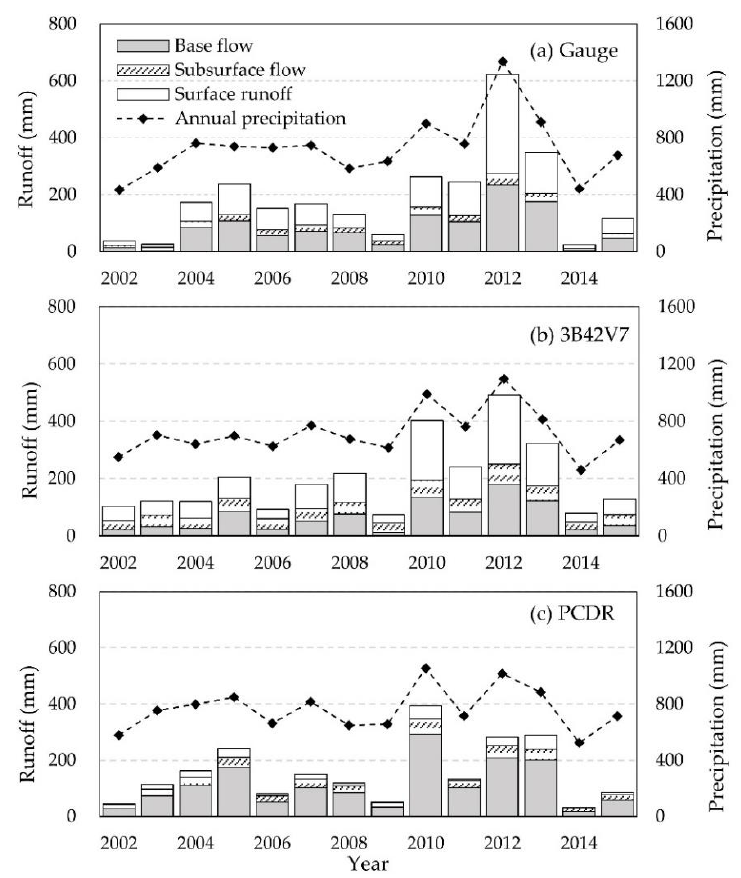
Figure 9. Annual runoff components from ( a ) gauge-, ( b ) 3B42V7-, and ( c ) PCDR-based simulations.